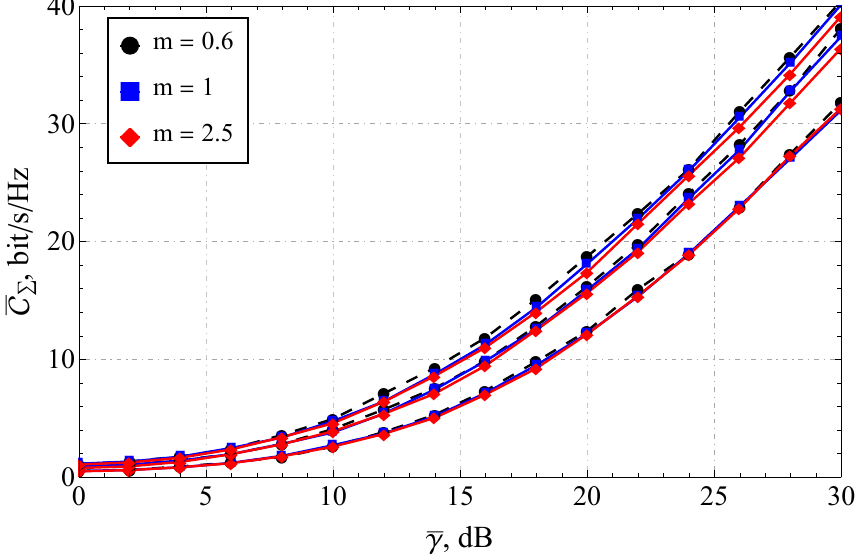
Figure 1. Ergodic capacity C Σ of the 8 × 8 MIMO system for various m and correlation